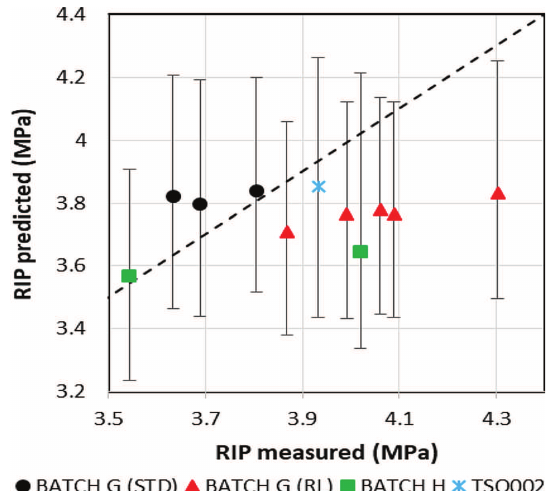
Fig. 3. Best estimate plus uncertainties of rod internal pres- sure (RIP) at EOL for different rod designs (distinguished by symbols and colors).